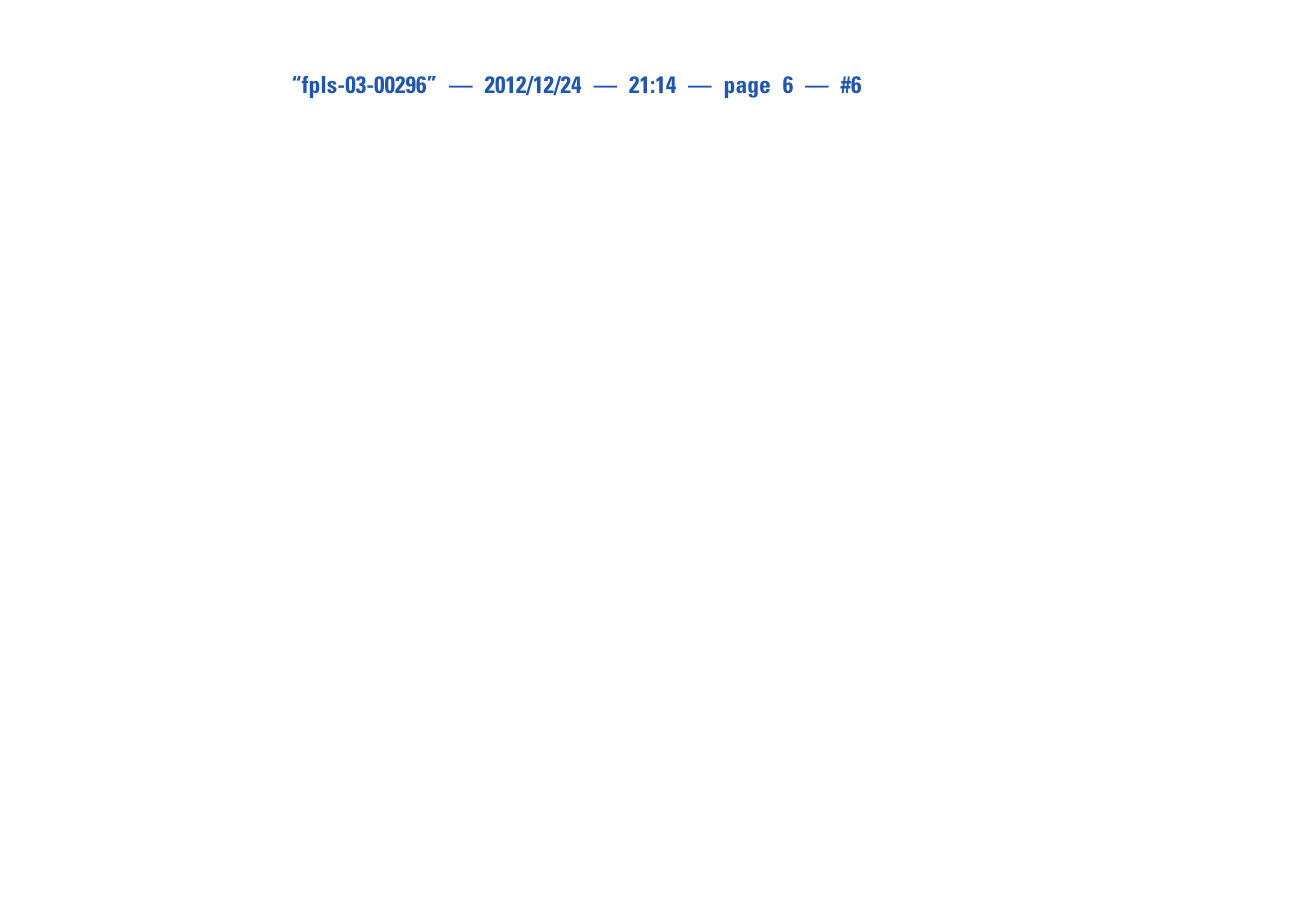
FIGURE 5 |A model for strigolactone reception. A model for the reception and signal transduction of the SL signal by the α / β hydrolase DAD2 is shown. DAD2 binds and reacts with SL, changing conformation to form DAD2*. DAD2* interacts with the F-box protein PhMAX2A and the other partners of